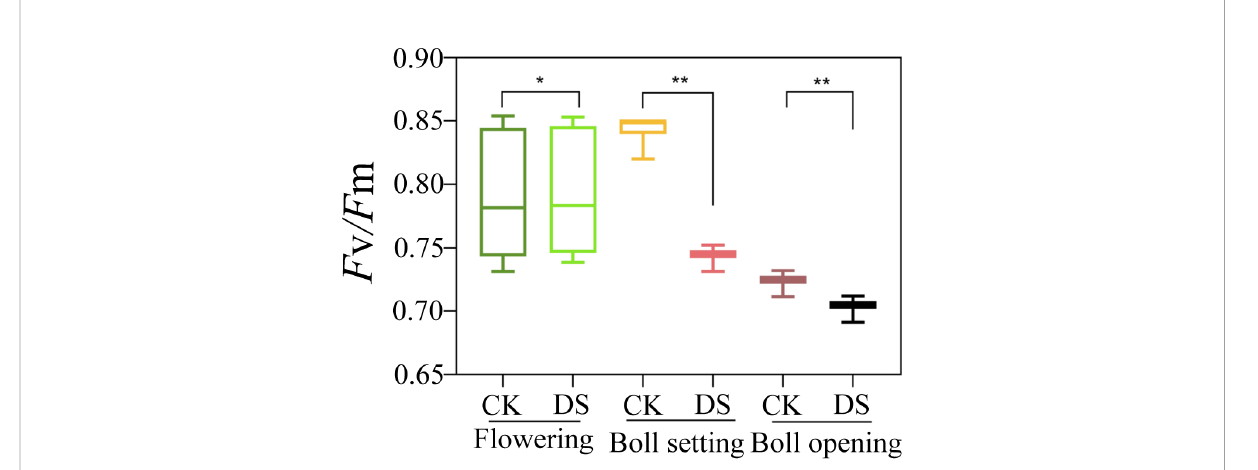
FIGURE 3 Effects of drought stress on F v /F m at the fl owering, boll setting, and boll opening stages. CK, normal conditions; DS, drought stress. * and ** indicate signi fi cance at the 0.05 and 0.01 probability levels,